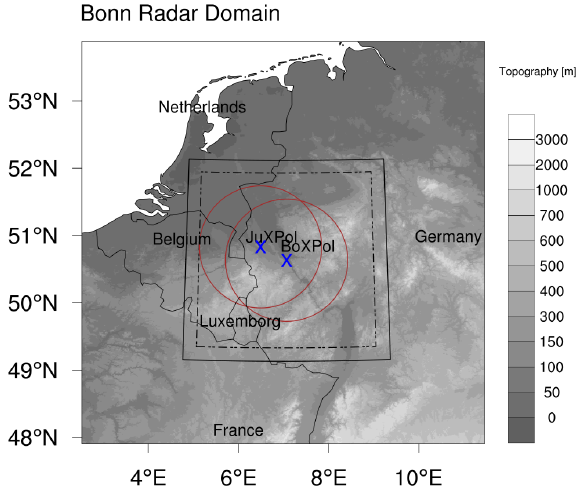
Figure 1. Spatial pattern of topography over the study region. The Bonn radar domain is outlined in solid line, including the coverage of BoXPol and JuXPol (red circles). The dotted lines indicate the inner domain (excluding the relaxation zone) used to compute the domain average